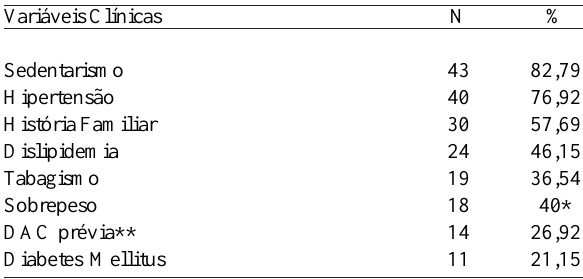
Tabela 2. Fatores de risco apresentados pelos pacientes com IAM. São José do Rio Preto - SP, 2011: